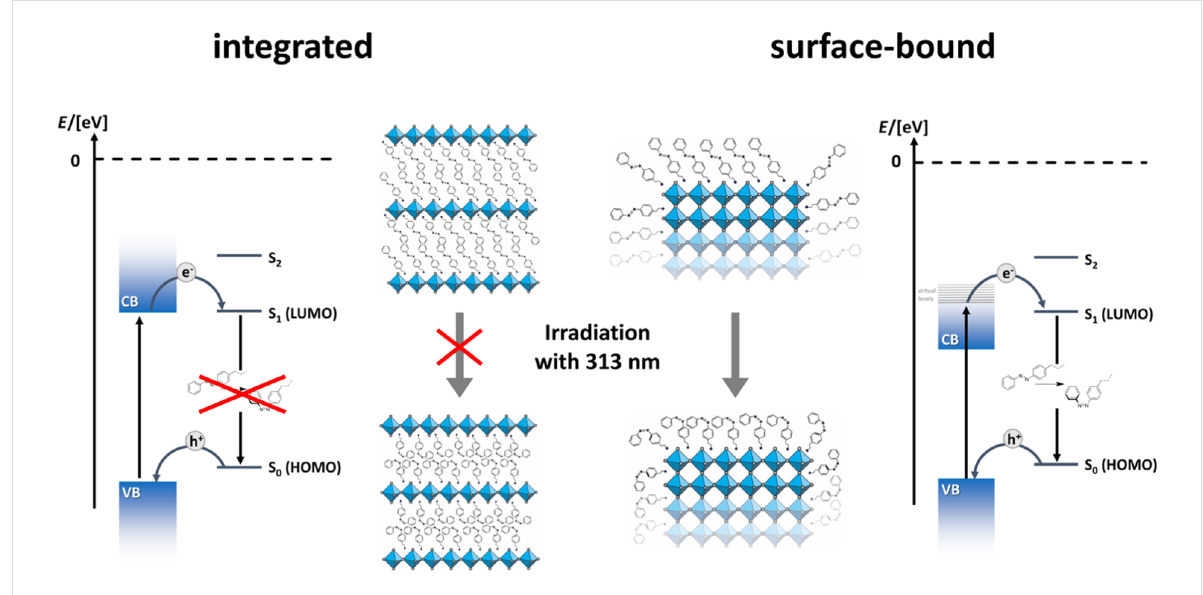
Figure 7: Comparison of the photoisomerisation and interfacial charge transfer processes for azobenzene incorporated into the hybrid perovskite phase (2D-system; left), and on the surface of the particles.